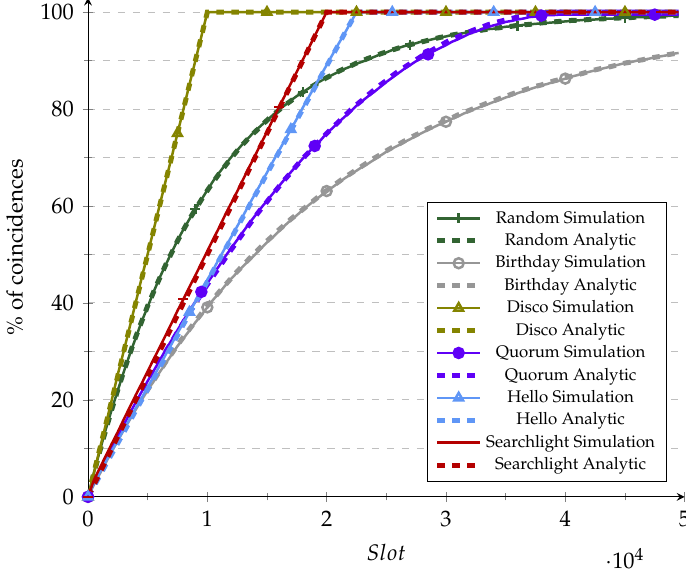
Figure 10. Validation of the simulation vs. analytic models for 1% duty